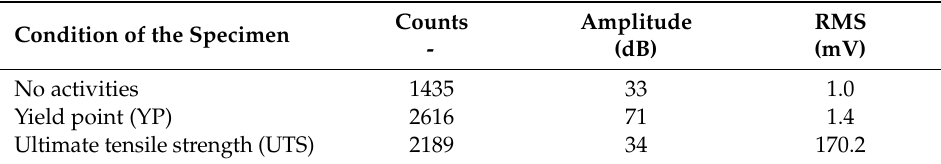
Table 2. Values of chosen parameters recorded in characteristic moments during the test for Sample No.